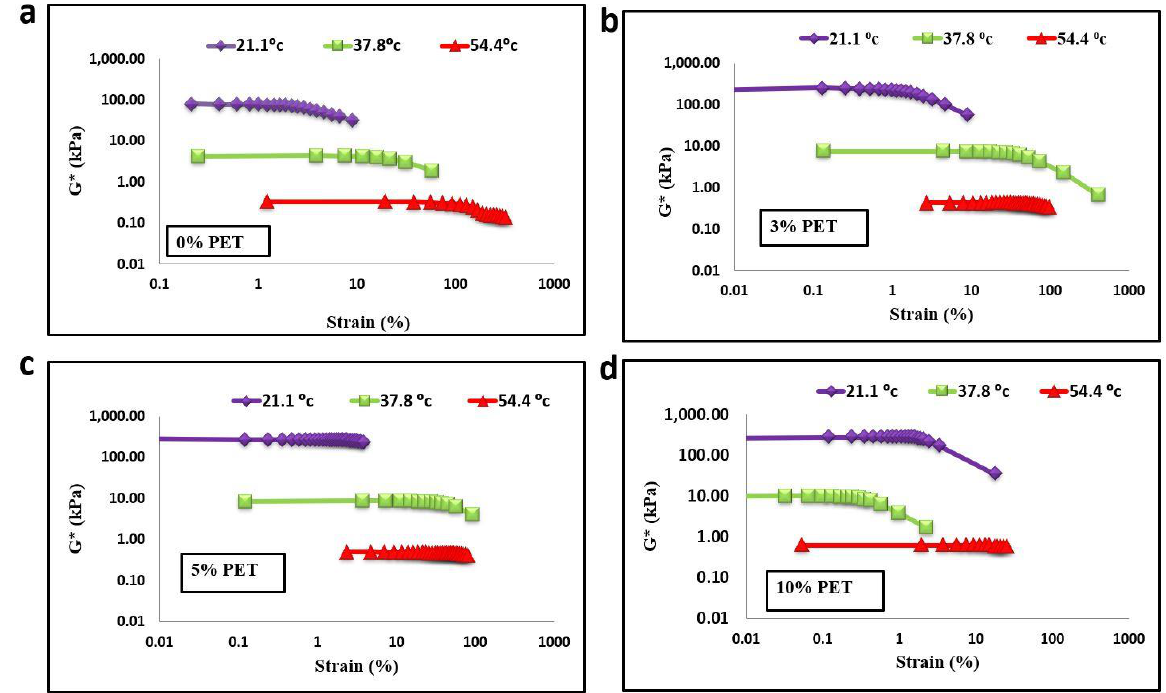
Figure 5. Linear viscoelastic range of unaged binder with PET content of ( a ) 0%, ( b ) 3%, ( c ) 5%, and ( d ) 10%. Materials 2020 , 13 , x FOR PEER REVIEW